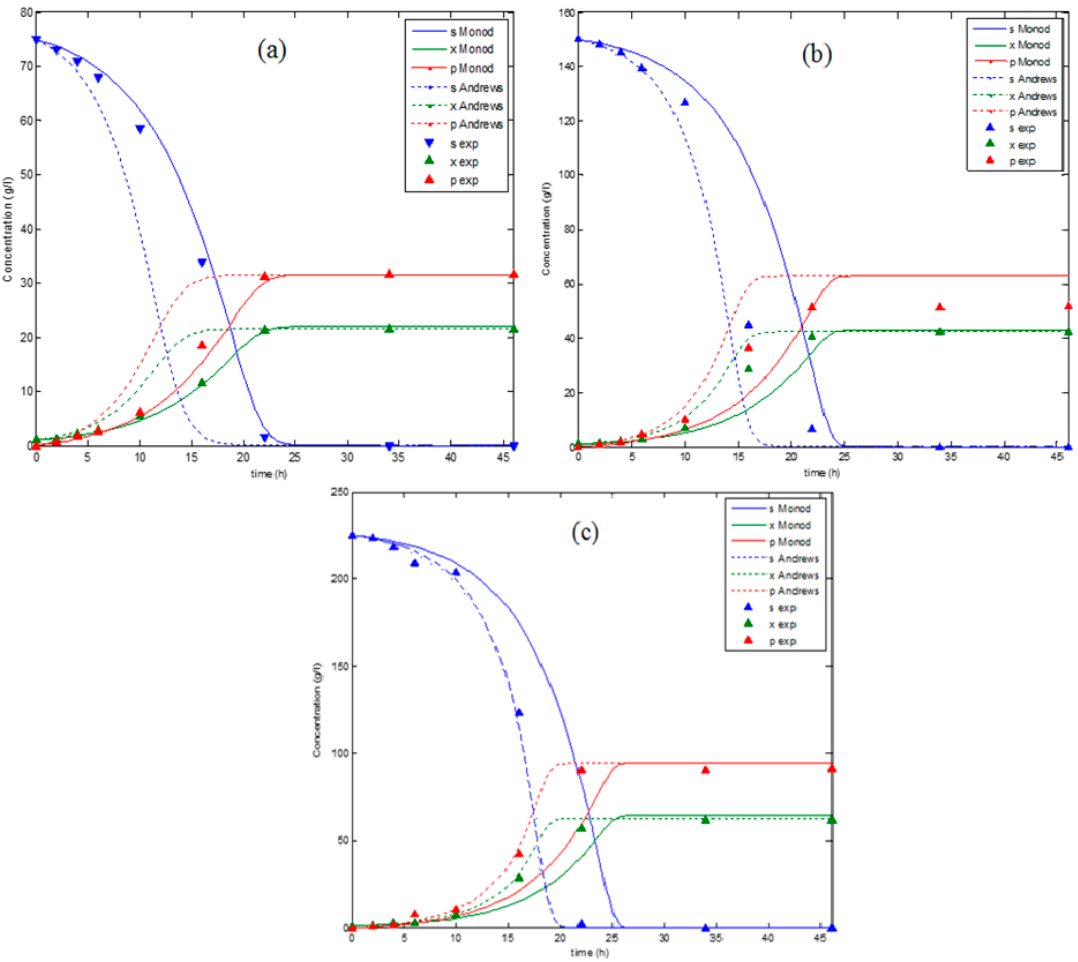
Figure 4. A comparison between the models’ data and the experimental data for x 0 = 1 g.L − 1 at di ff erent substrate concentrations: ( a ) S 0 = 75 g.L − 1 , ( b ) S 0 = 150 g.L − 1 , and ( c ) S 0 = 225 g.L − 1 .